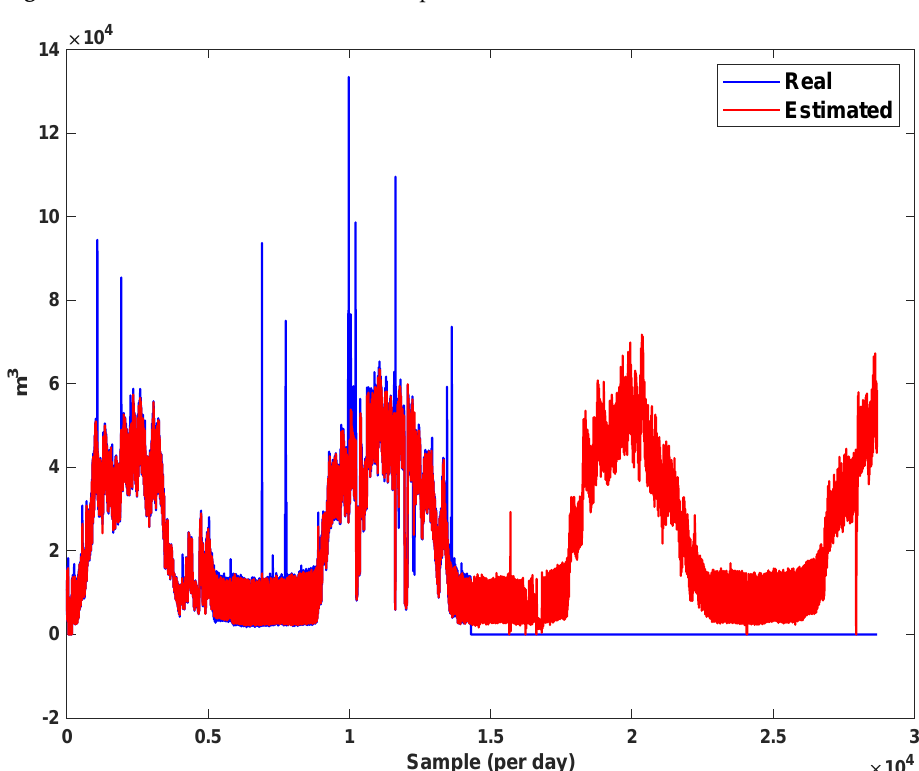
Figure 23. Detection fault 1: Peak of